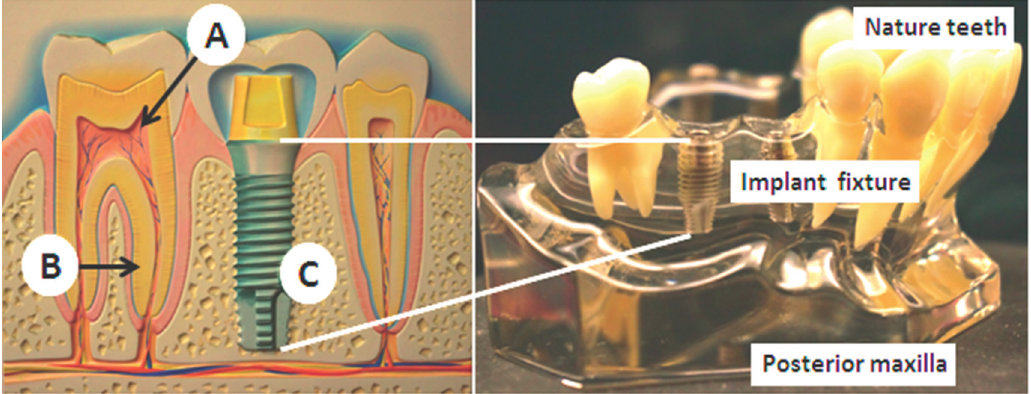
Figure 1. The intra-oral environment over maxilla and the tooth structures. The pain origins are mainly from the pulp structures (A), and the periodontal ligament (B). After artificial implant restoration (C), they are both